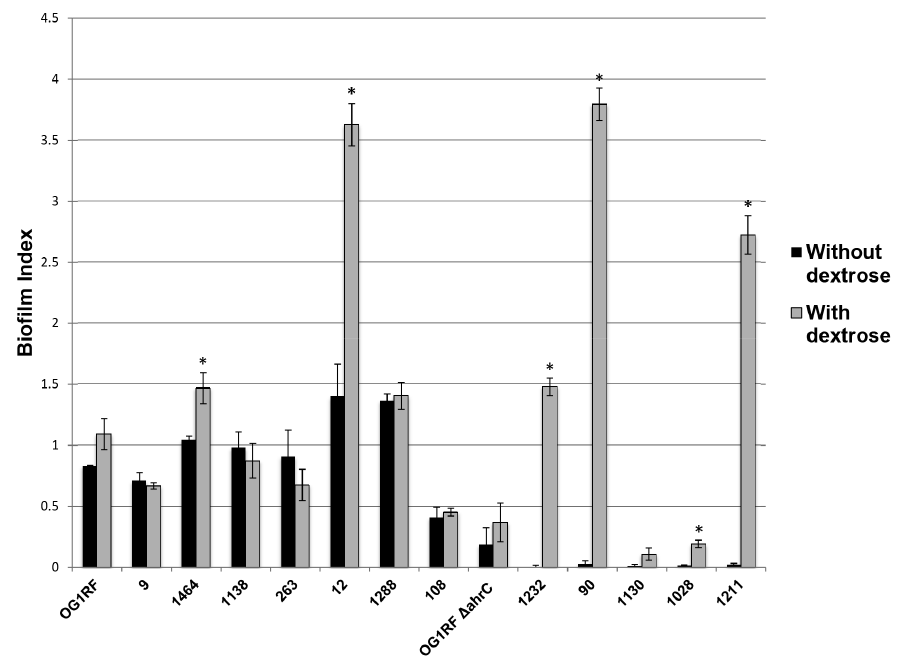
Figure 5. Biofilm index of clinical Enterococcusfaecalis isolates grown in tryptic soy broth (TSB) with and without dextrose. Six isolates that showed high-level biofilm formation (biofilm index . 1) (OG1RF, 9, 1464, 1138, 263, 12, and 1288), one with moderate biofilm formation (biofilm index 0.4) (180), and five that showed low-level biofilm formation (biofilm index , 0.1) (OG1RF D ahrC , 1232, 90, 1130, 1028, and 1211) in the standard assay (TSB without dextrose) were evaluated using TSB supplemented with dextrose (0.75% dextrose). Error bars represent standard deviation. *indicates p , 0.01 for comparison of biofilm formation with and without dextrose.